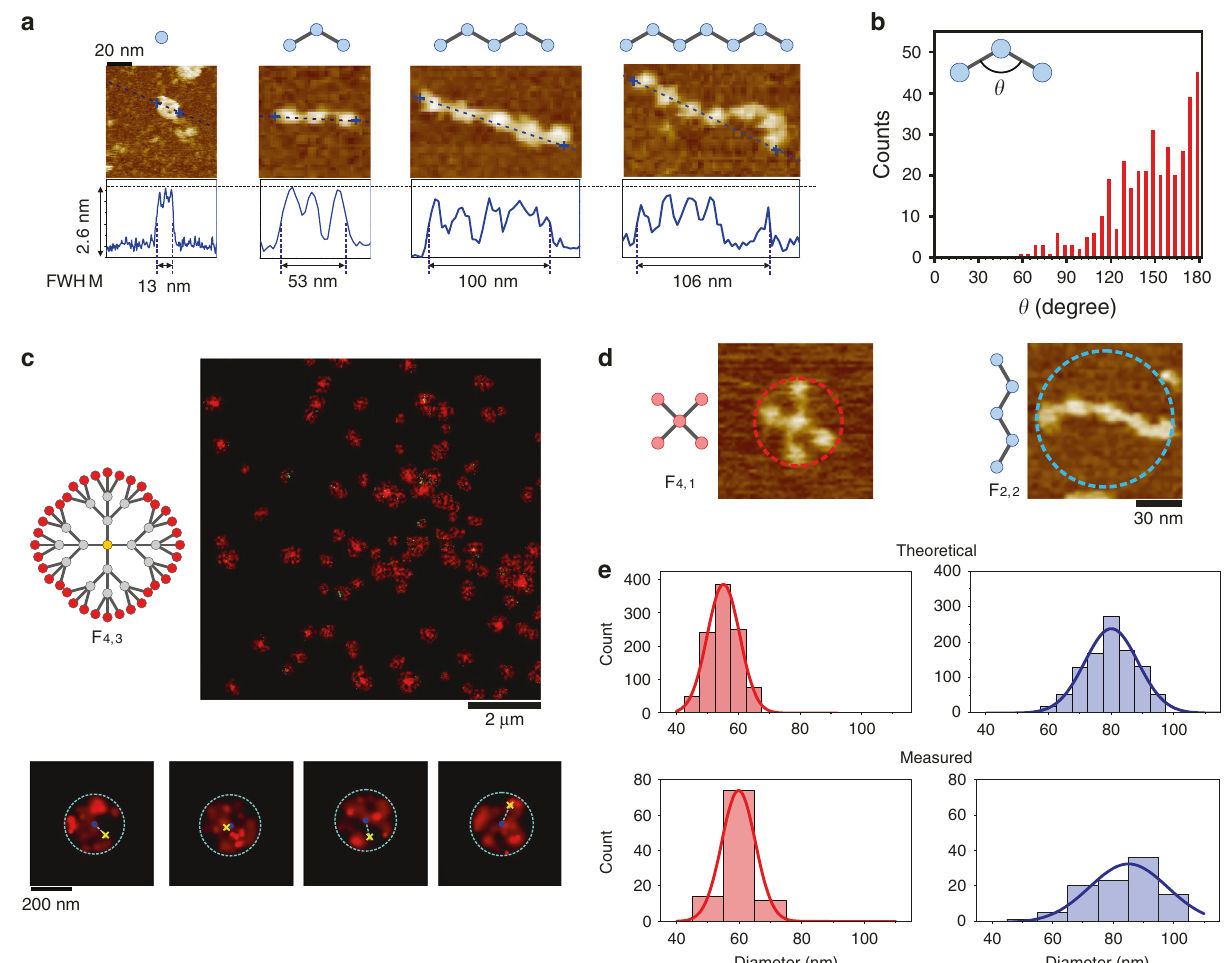
Fig. 2 FDFs with topologically engineered structural compactness. a Schematic structures of F 2,i ( i = 0-3) with representative atomic force microscopic (AFM) images and line pro fi les across both terminal tetrahedral DNA nanostructures (TDNs) (marked with blue cross) for F 2,i . The full width of half maximum height (FWHM) are measured from the line pro fi les. b Histogram statistics of the inter-node angles in F 2,i ( N = 360). c Schematic structures of F 4,3 and their stochastic optical reconstruction microscopic (STORM) images (large view and individual speckles magni speckle, Gaussian speckle (surrounded by blue dashed circle) resulted from Alexa647 labelled on the outer-shell TDNs. Yellow cross, fl uorescence location of the root TDN (Cy3). Blue dot, geometric centre of the circle. d Schematic and representative AFM images of F 4,1 and F 2,2 . e Diameter distribution of F 4,1 and F 2,2 from theoretical simulations ( N = 1000) and AFM measurements ( N = 100). Curves are Gaussian fi ttings of the